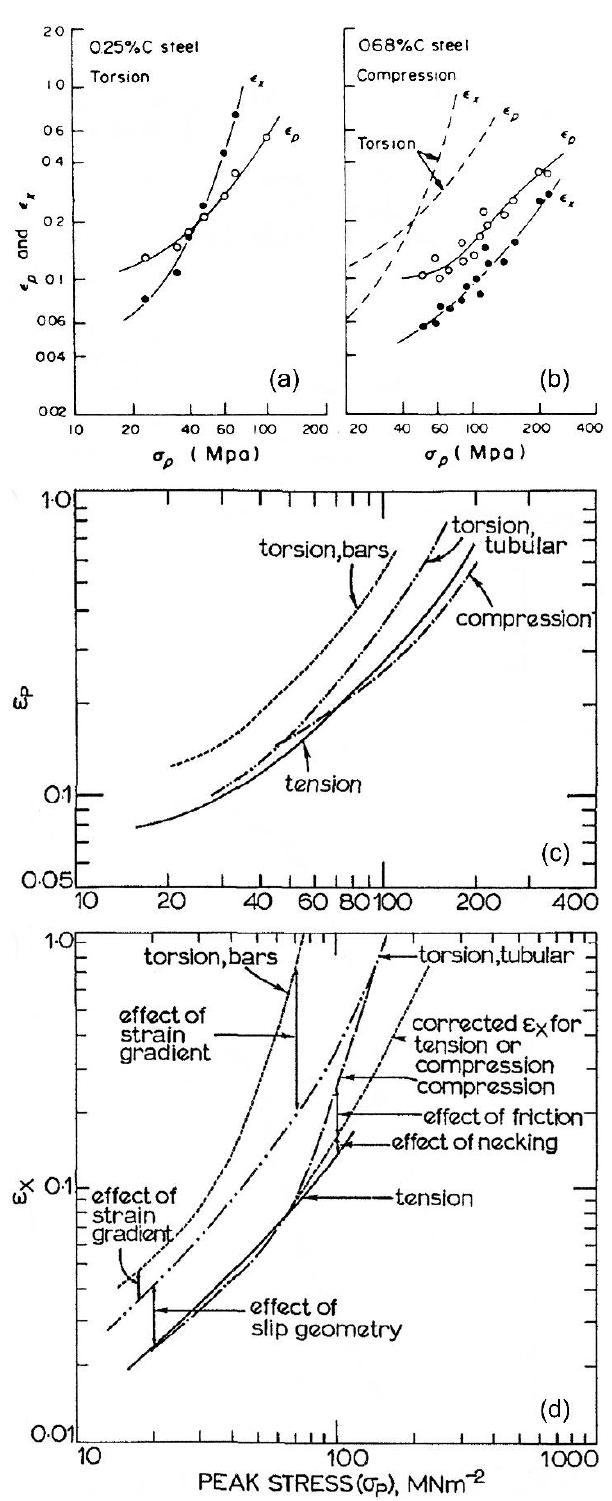
Figure 2. ( a , b ) E ff ect of test type on ε p and ε x for plain C steels. ( c ) Same than ( a , b ) but including Figure 2. ( a ) and ( b ) Effect of test type on ε p and ε x for plain C steels. ( c ) Same than ( a ) and ( b ) but tubular torsion and tensile tests. ( d ) E ff ect of other artifacts such as necking, strain gradient, and so on, including tubular torsion and tensile tests. ( d ) Effect of other artifacts such as necking, strain gradient, on ε x [( a , b ) reprinted from ref. [7] and ( c , d ) from ref. [27] with permission from Elsevier and Taylor & and so on, on ε x [( a ) and ( b ) reprinted from ref. [7] and ( c ) and ( d ) from ref. [27] with permission Francis from Elsevier and Taylor & Francis respectively Also, the initial grain size has a notorious influence on the DRX kinetics and microstructure owing to changes in the grain-boundary surface area conditions, thus affecting the nucleation kinetics. The finer the microstructure (initial grain size), the lower the critical and peak strains. Dislocations can